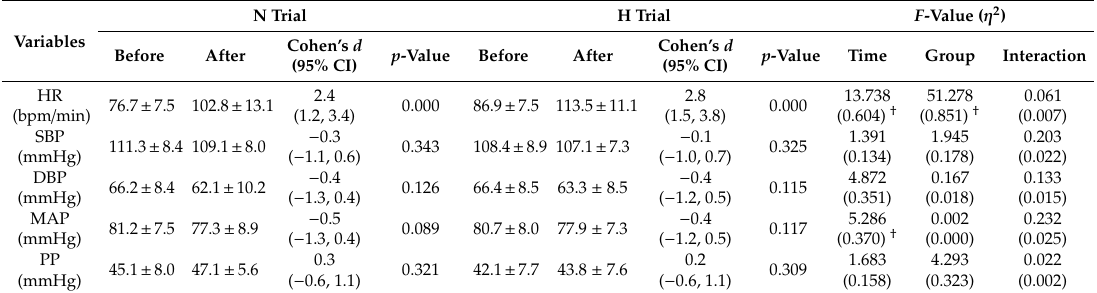
Table 3. Blood pressure data before and after the Pilates program in the N trial and H trial